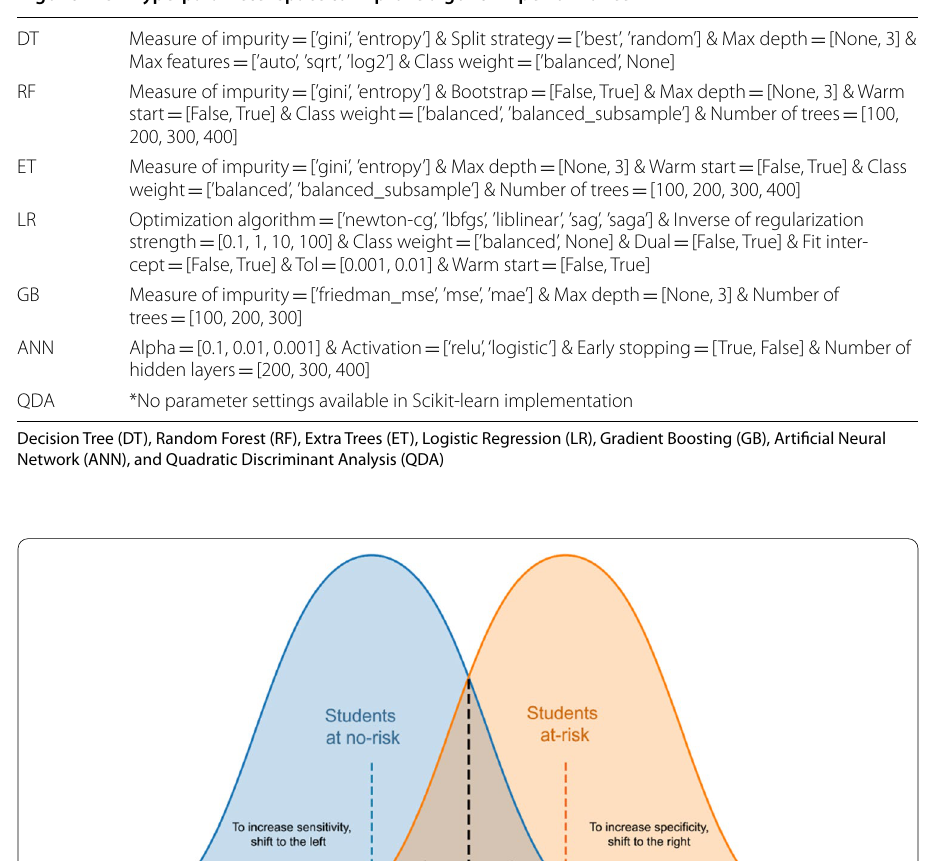
Table 4 Grid-search parameters for each candidate algorithm Algorithms Hyperparameter space to improve algorithm performance